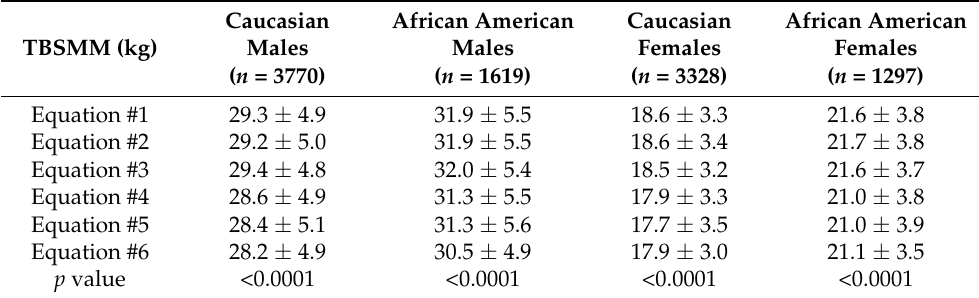
Table 2. Mean ± standard deviation values of the total body skeletal muscle mass (TBSMM) estimates obtained for the four groups by using the six equations proposed by Kim et al. [10,11].